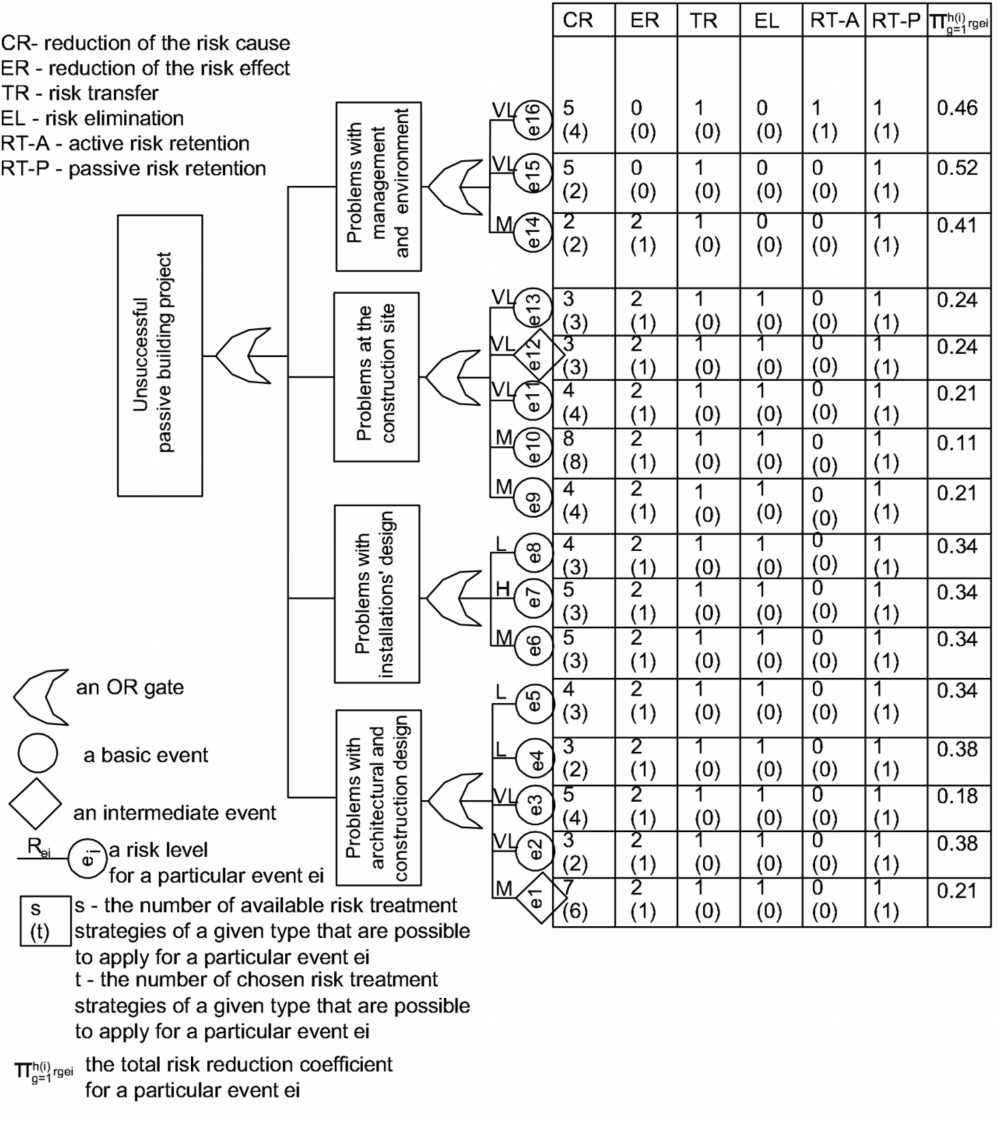
Figure 2. Proposed hybrid Fuzzy Fault Tree and Risk Response Matrix for risk management in passive buildings projects (on the example of Polish